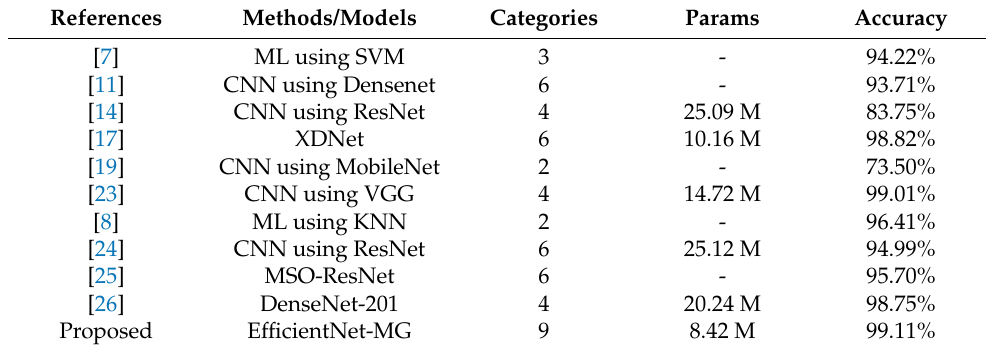
Table 9. Comparison with existing studies for ALD